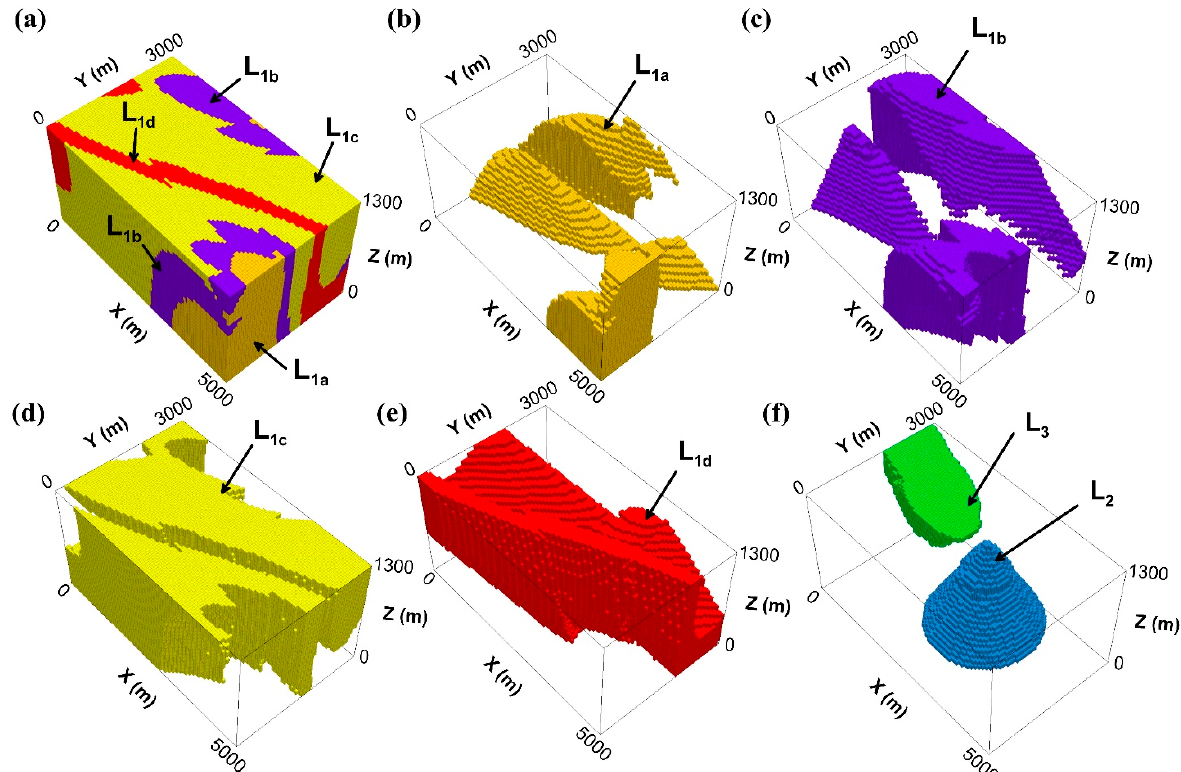
Figure 3. Construction of geological features. Reference geological model was selected at the end of stage 12 with three major geological features: a background geology ( L 1a , L 1b , L 1c , L 1d ) and two sepa- rate alteration overprints overlapped over the background geological features ( L 2 , L 3 ).